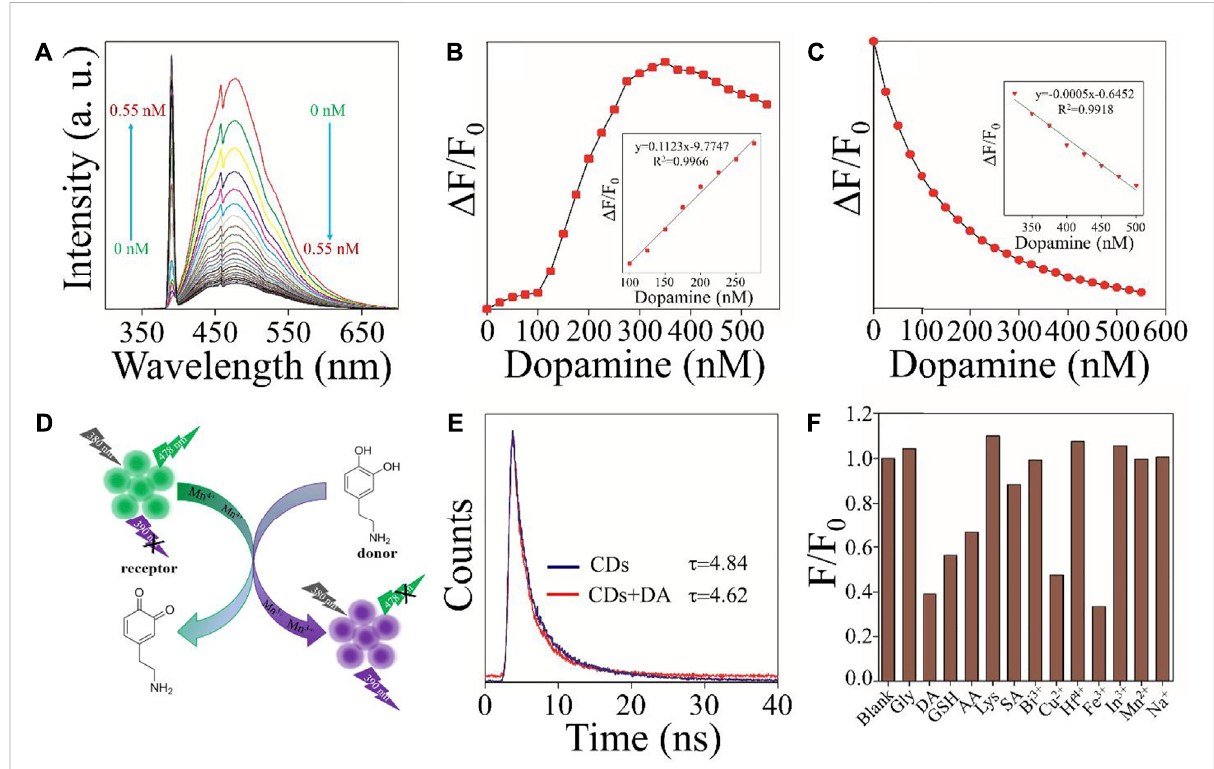
FIGURE 3 Mn 3+ /Mn 4+ ion-dopedCDs for DA detection (A) Effect of DA content on the fl uorescence intensity of Mn 3+ /Mn 4+ ion-dopedCDs. (B) The curve relationship between fl uorescence intensity at 390 nm and DA (0 – 550 nM) content (inset: the linear relationship between Δ F/F 0 and DA content (100 – 275 nM)) (C) The curve relationship between fl uorescence intensity at 478 nm and DA (0 – 550 nM) content (inset: the linear relationship between Δ F/F 0 and DA (325 – 525 nM) content (D) Schematic illustration of the mechanism of Mn 3+ /Mn 4+ ion-doped CDs for DA detection. (E) The fl uorescence decay curves of Mn 3+ /Mn 4+ ion-doped CDs in an aqueous solution without and with DA. (F) Anti-interference of fl uorescence intensity of Mn 3+ /Mn 4+ ion-doped CDs at 478